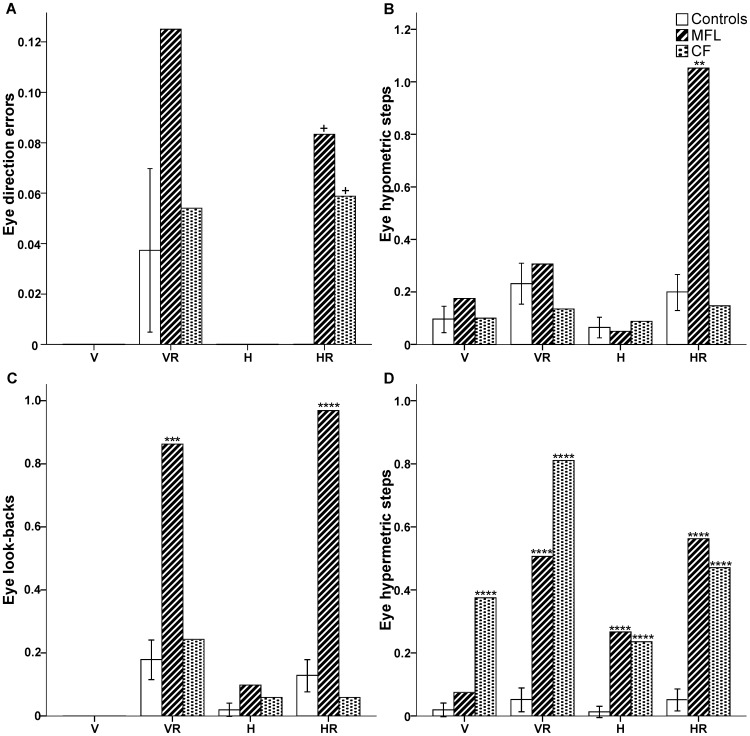
Mean eye errors performed by MFL, CF, and the control group.(A) Eye direction errors (B) hypometric steps (C) look-backs (D) hypermetric steps that have been normalized as a ratio per trial across all targets for four conditions (V = Vertical; VR = Vertical Rotated; H = Horizontal; HR = Horizontal Rotated). Both hands were pooled for MFL and CF. Note an increase in oculomotor errors for both MFL and CF during the conditions with rotated visual feedback (VR/HR). Error bars denote 95% Confidence Intervals. + No statistical comparison between the case and the control group could be performed because the control group had a mean and variance of zero. **p′<0.01; ***p′<0.001; ****p′<0.0001.